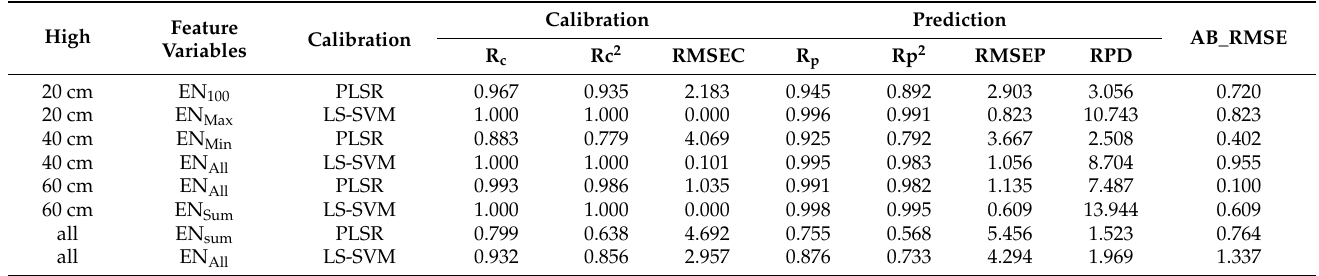
Table 3. Best models for the prediction of the time of occurrence of the impact on the